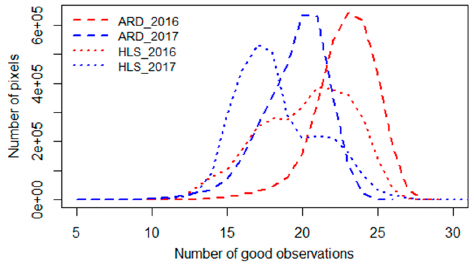
Figure 2. Number of good observations for Analysis Ready Data (ARD) and Harmonized Landsat Sentinel-2 (HLS) data in 2016 and